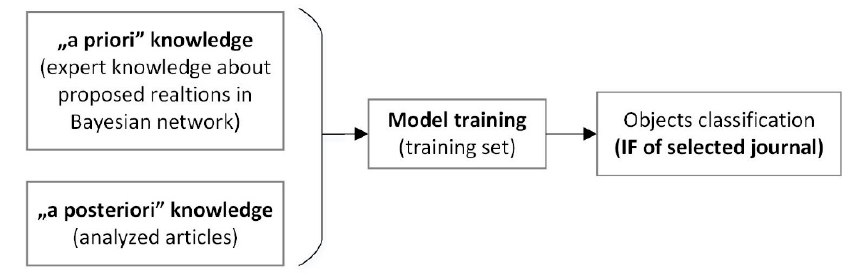
Figure 6. Learning Bayesian network for expert knowledge.